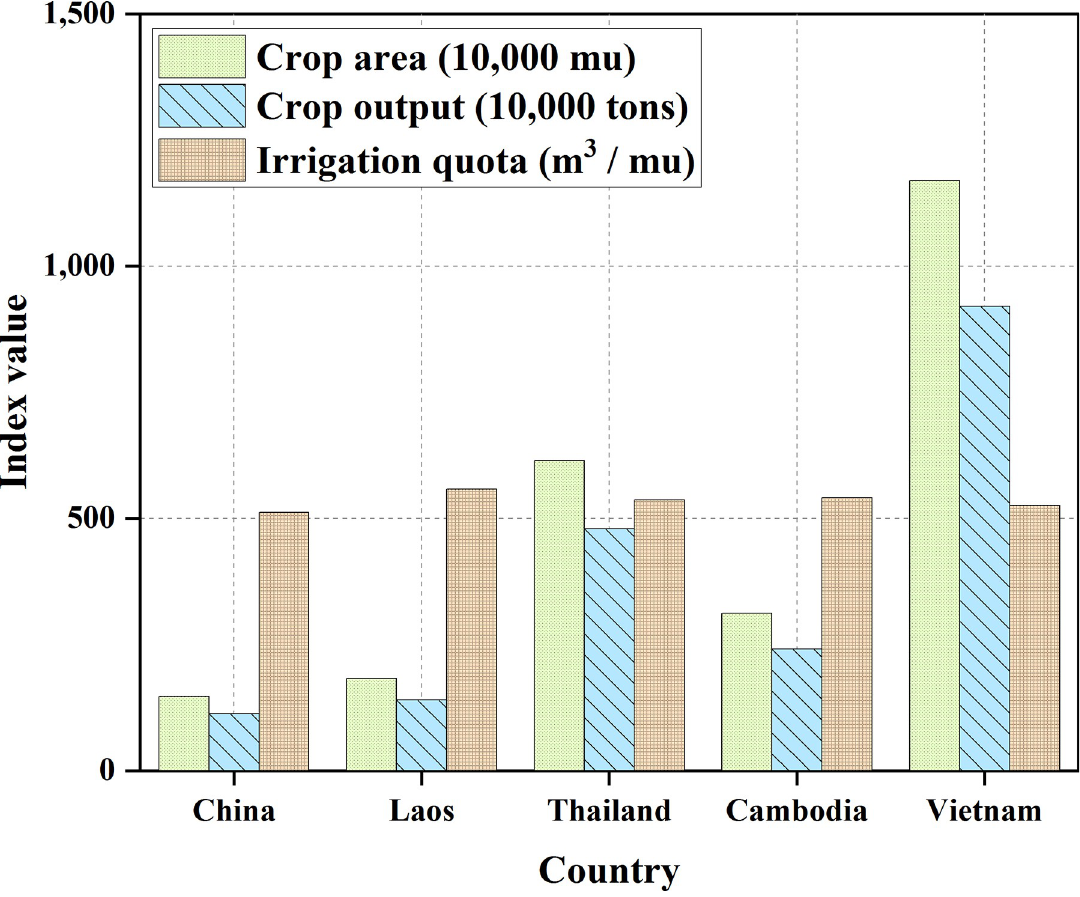
Fig 8. Comparison of crop conditions in various